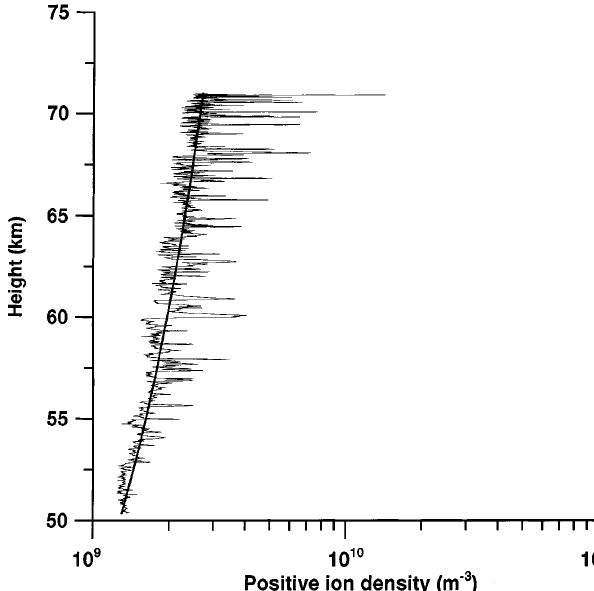
Fig. 5. The background positive ion density N densities N